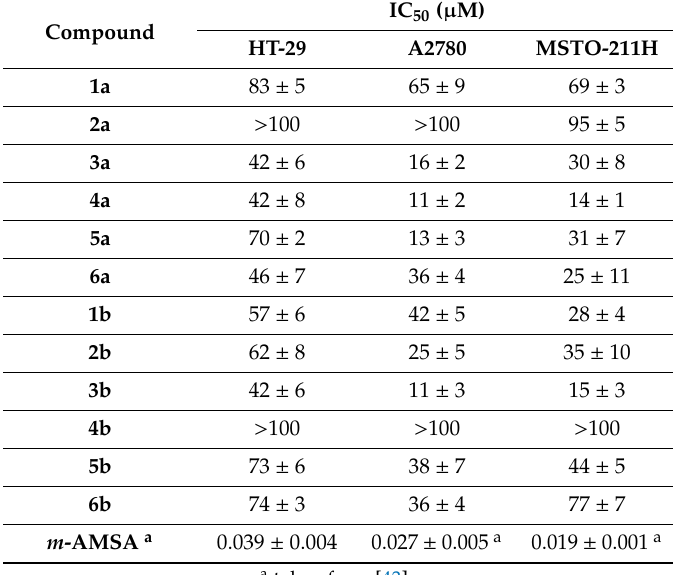
Table 2. Antiproliferative activity of compounds 1a – 6a and 1b – 6b on three human tumor cell lines. Meta-amsacrine ( m -AMSA) was reported as the